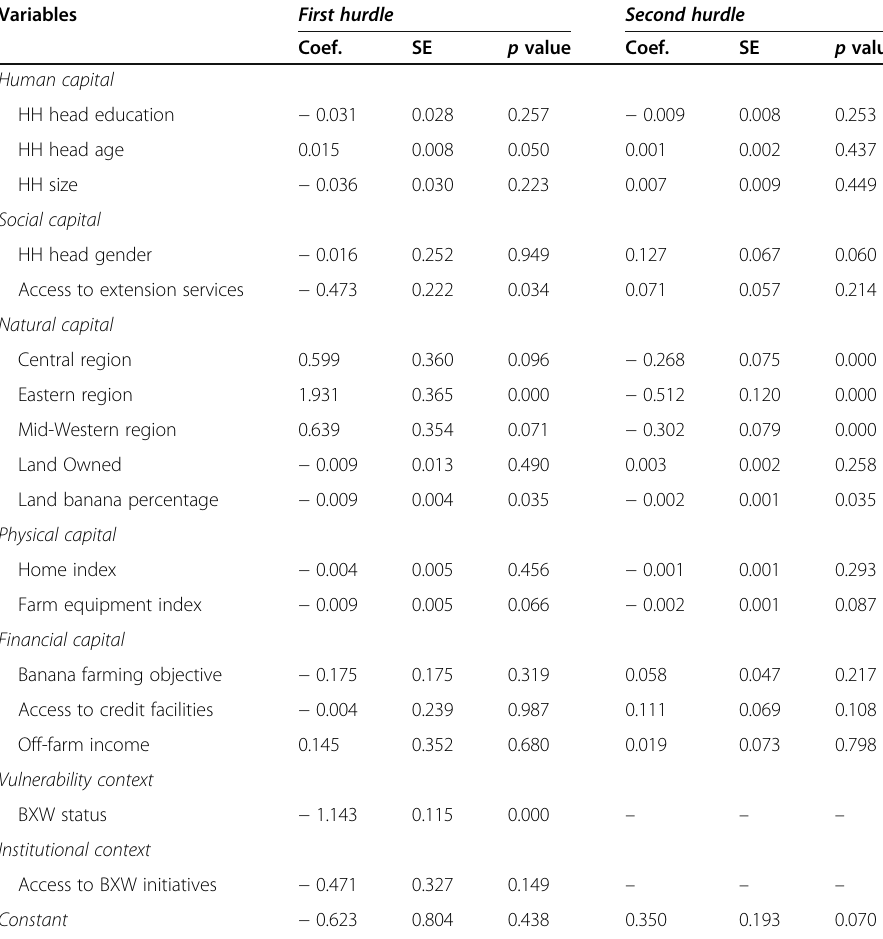
Table 6 Result of the Poisson-logit hurdle model